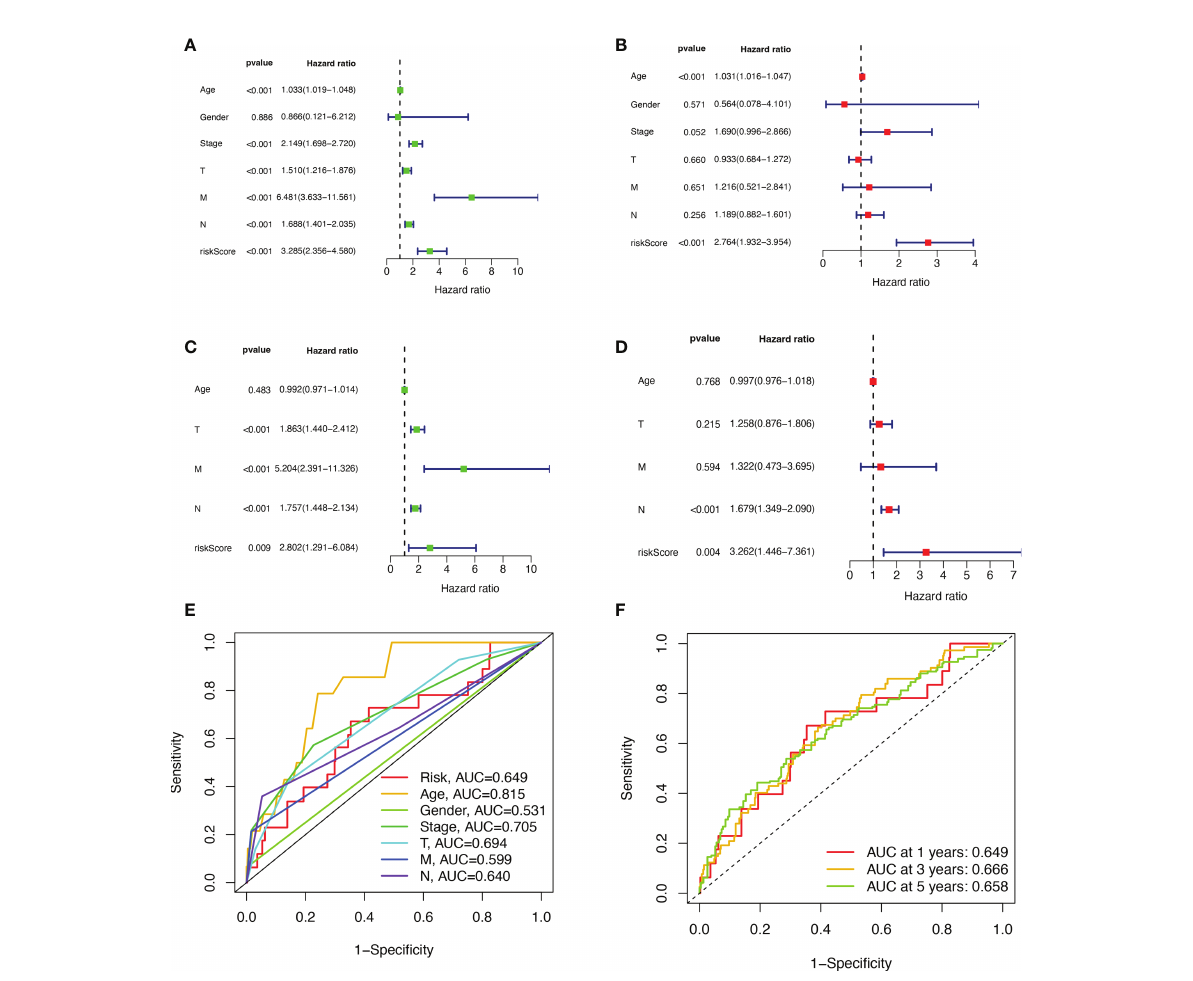
FIGURE 3 Validation of BMRGs prognosis and association with clinical parameters. (A, B) Univariate (A) and multivariate (B) Cox regression analyses of risk scores and clinical parameters in the training set (TCGA cohort). (C, D) Univariate (C) and multivariate (D) independent Cox regression analyses of risk scores and clinical parameters in the validation set (GEO cohort). (E) ROC curves and AUC for risk scores and clinicopathological characteristics. (F) ROC curves and AUC for 1-year, 3-year, and 5-year survival